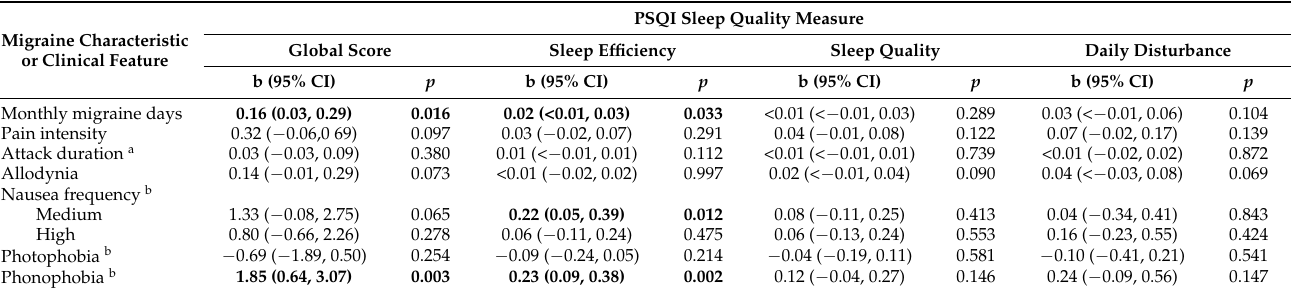
Table 5. Summary of migraine characteristics/clinical features in relation to overall and specific dimensions of sleep quality.